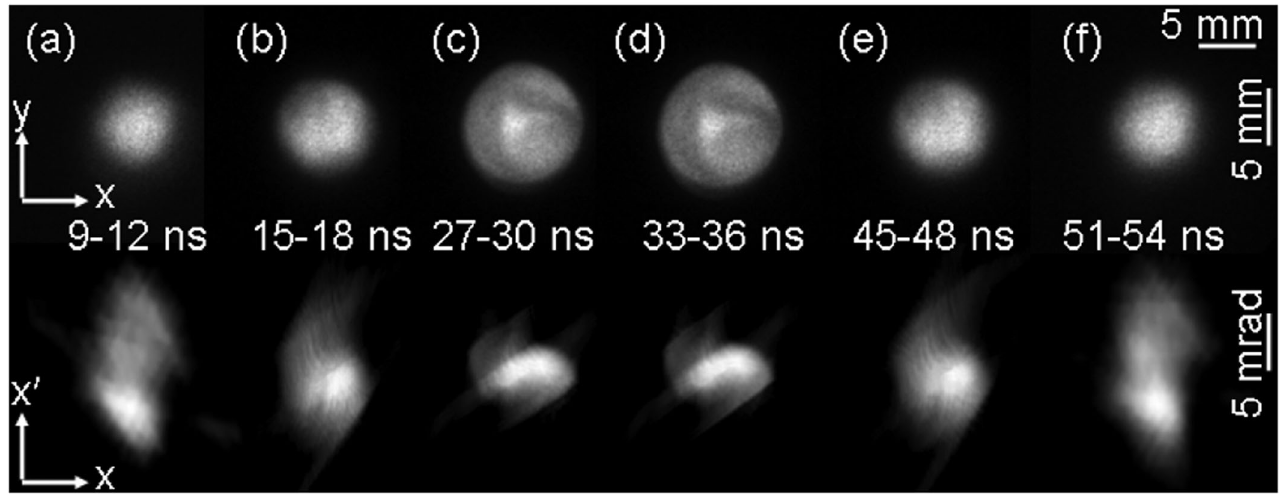
FIG. 7. Beam in configuration space (top) and in x - x 0 phase space (bottom) for slices a, b, c, d, e, and f, reconstructed at LC1. Phase spaces are generated using the initial conditions shown in Fig.